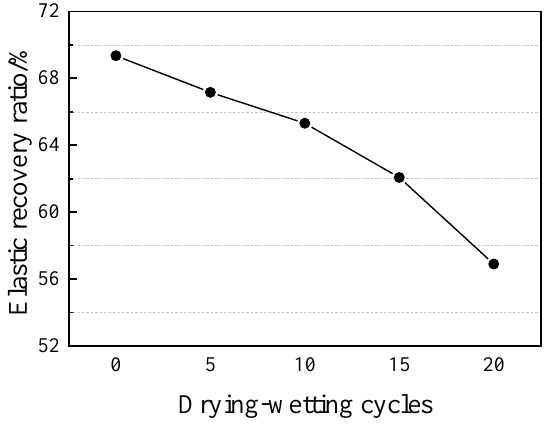
Figure 8. Elastic recovery ratio of PCFC under different drying–wetting cycles.